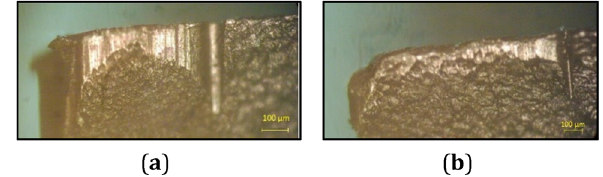
Figure 4: Flank wear after 500 mm cutting: ( a ) fl ank wear of the untreated cutting tool; ( b ) fl ank wear of the permanent magnet